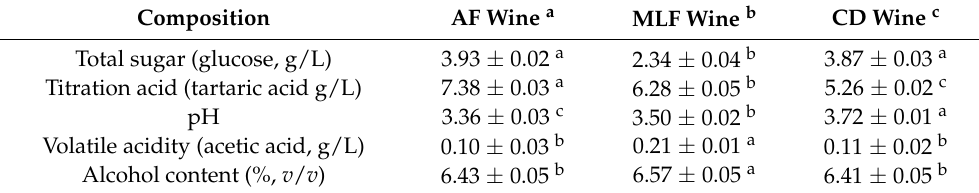
Table 3. Physicochemical properties of three pear-kiwifruit wines.